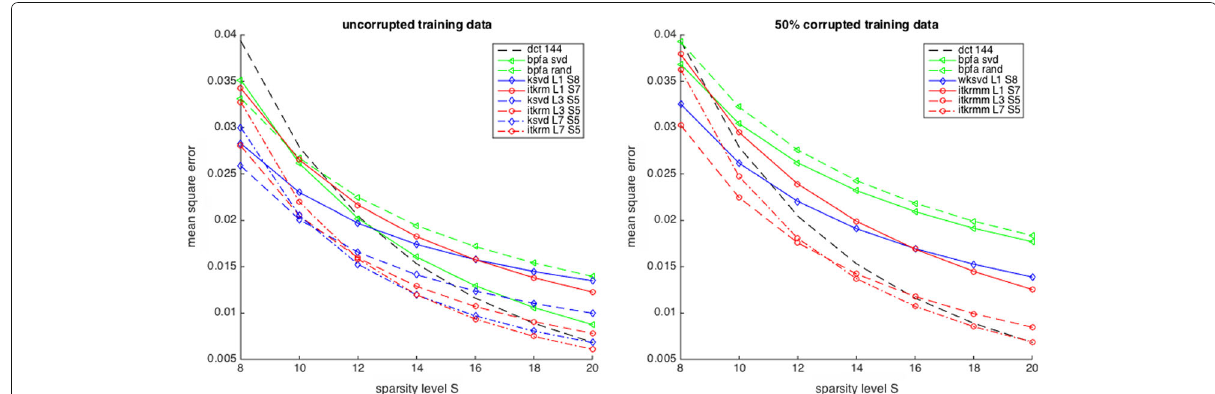
Fig. 8 Approximation quality of dictionaries with low-rank components of various sizes on Barbara , DCT144 as well as BPFA, (w)KSVD and ITKrM(M) learned on uncorrupted data (left) and on 50% corrupted data